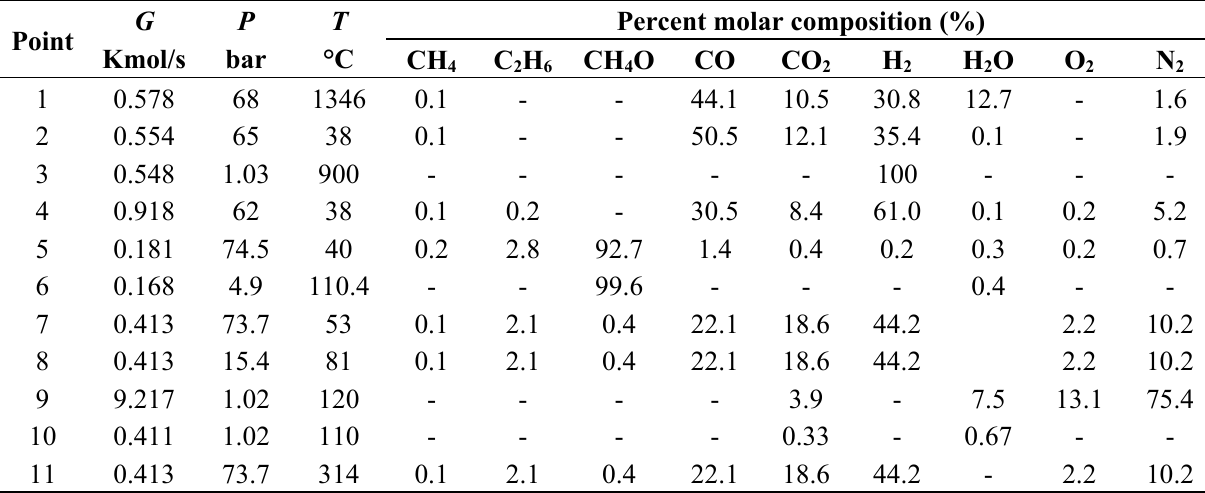
Table 1. Parameters of the main points of the MES